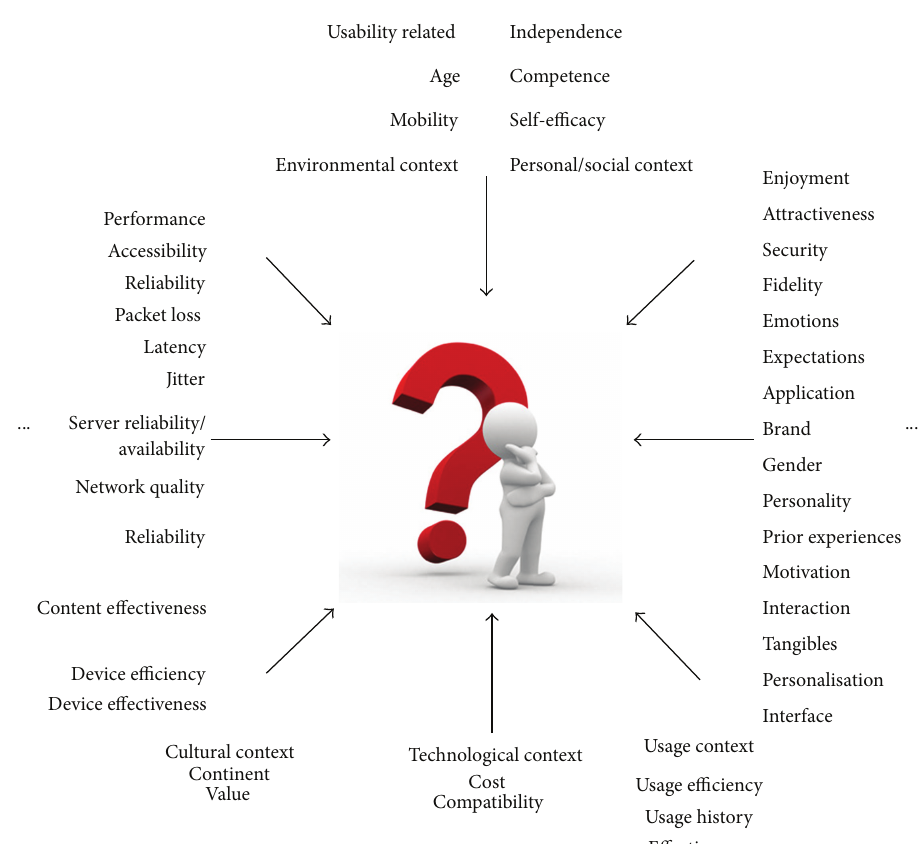
Figure 1: Different factors to be considered in relation to